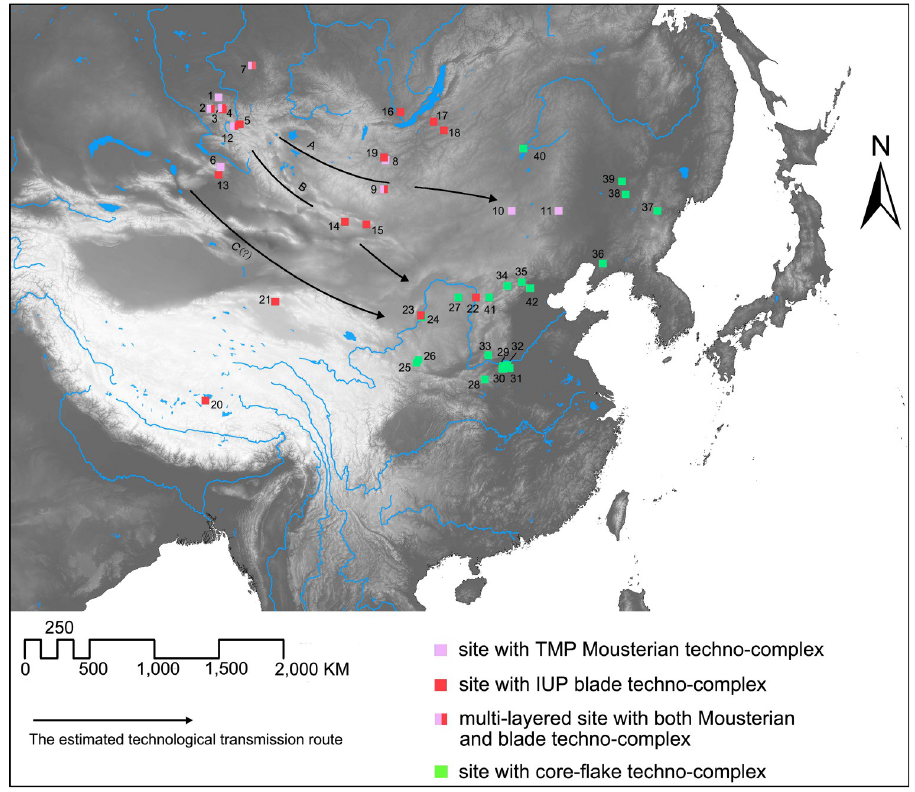
Fig 3. The distributional pattern of the sites with different techno-complexes and the estimated technological transmission route between Mongolia/Siberia and northern China between 50–32 cal ka BP. The base map raster is made from the USGS digital elevation map data from http://earthexplorer.usgs.gov/. (1: Okladnikov cave; 2: Strashnaya cave; 3:Denisova cave; 4: Ust Karakol; 5: Kara-Tenesh; 6: Tongtiandong; 7: Mokhovo-2; 8: Kharganyn